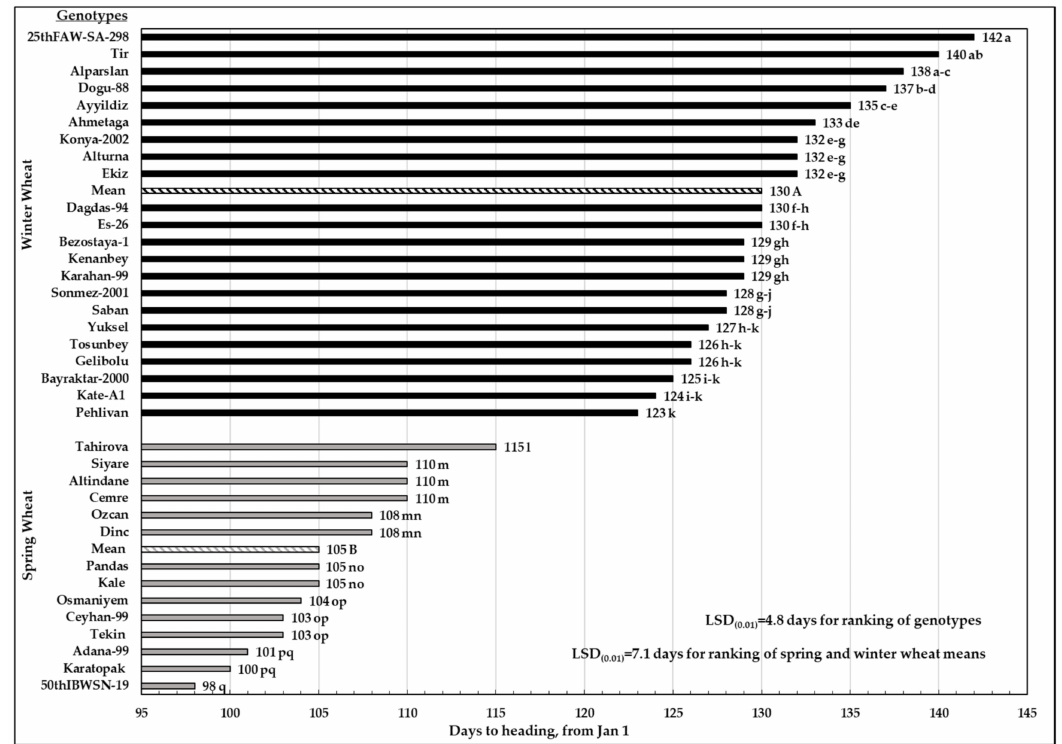
Figure 4. Comparing winter wheat genotypes with spring wheat genotypes for days to heading over two cropping seasons. Genotypes with the same letter are not significantly